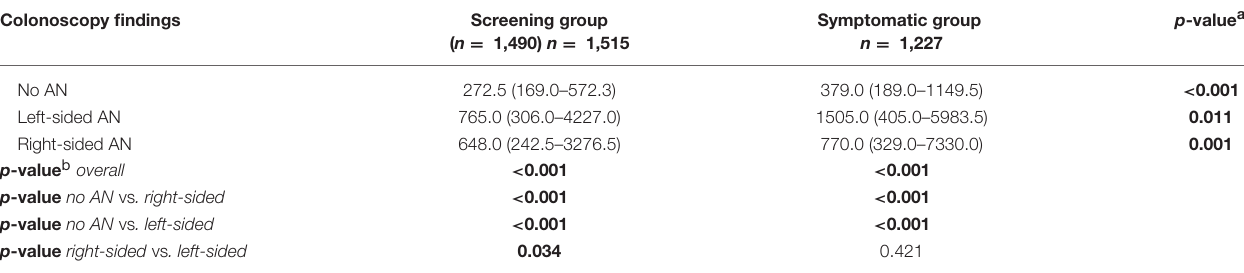
TABLE 6A | Hemoglobin FIT values according to colonoscopy findings location (left-sided, right sided). Colonoscopy findings